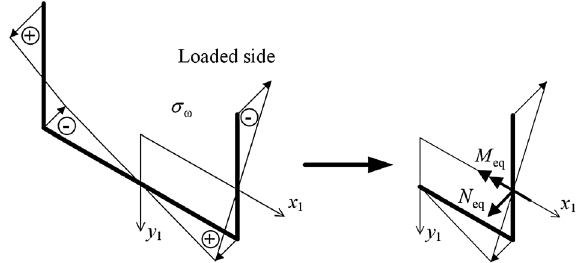
Fig. 13 Equivalent action of normal stresses by warping moment at mid-span.